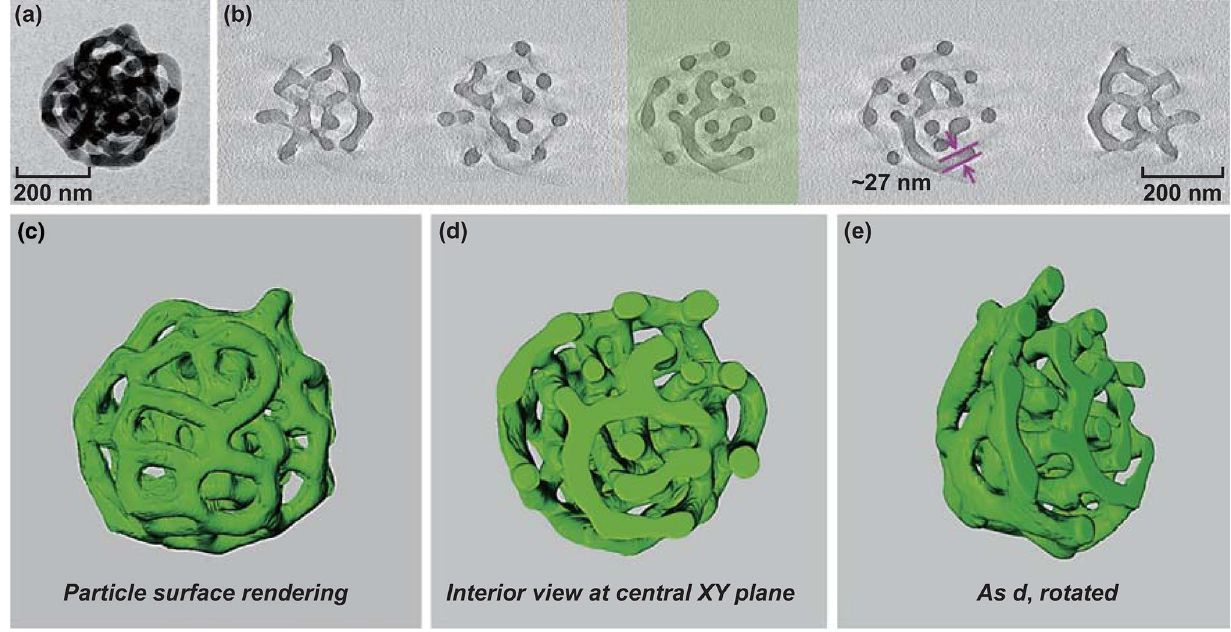
Fig. 4 TEM analysis of the PS‑ b ‑P2VP templates: a normal TEM image and b selected XY slices through the tomographic reconstruction of an individual PS‑ b ‑P2VP porous particle. The highlighted green slice in b corresponds to the central slice d . c – e 3D particle surface renderings with and without interior views, using a cutting plane through the central XY slice (PS‑ b ‑P2VP shown in green). (Color figure